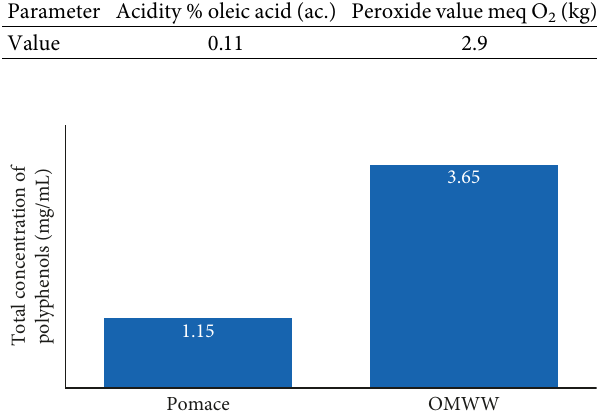
Figure 2: Total polyphenol concentration in olive by-products.